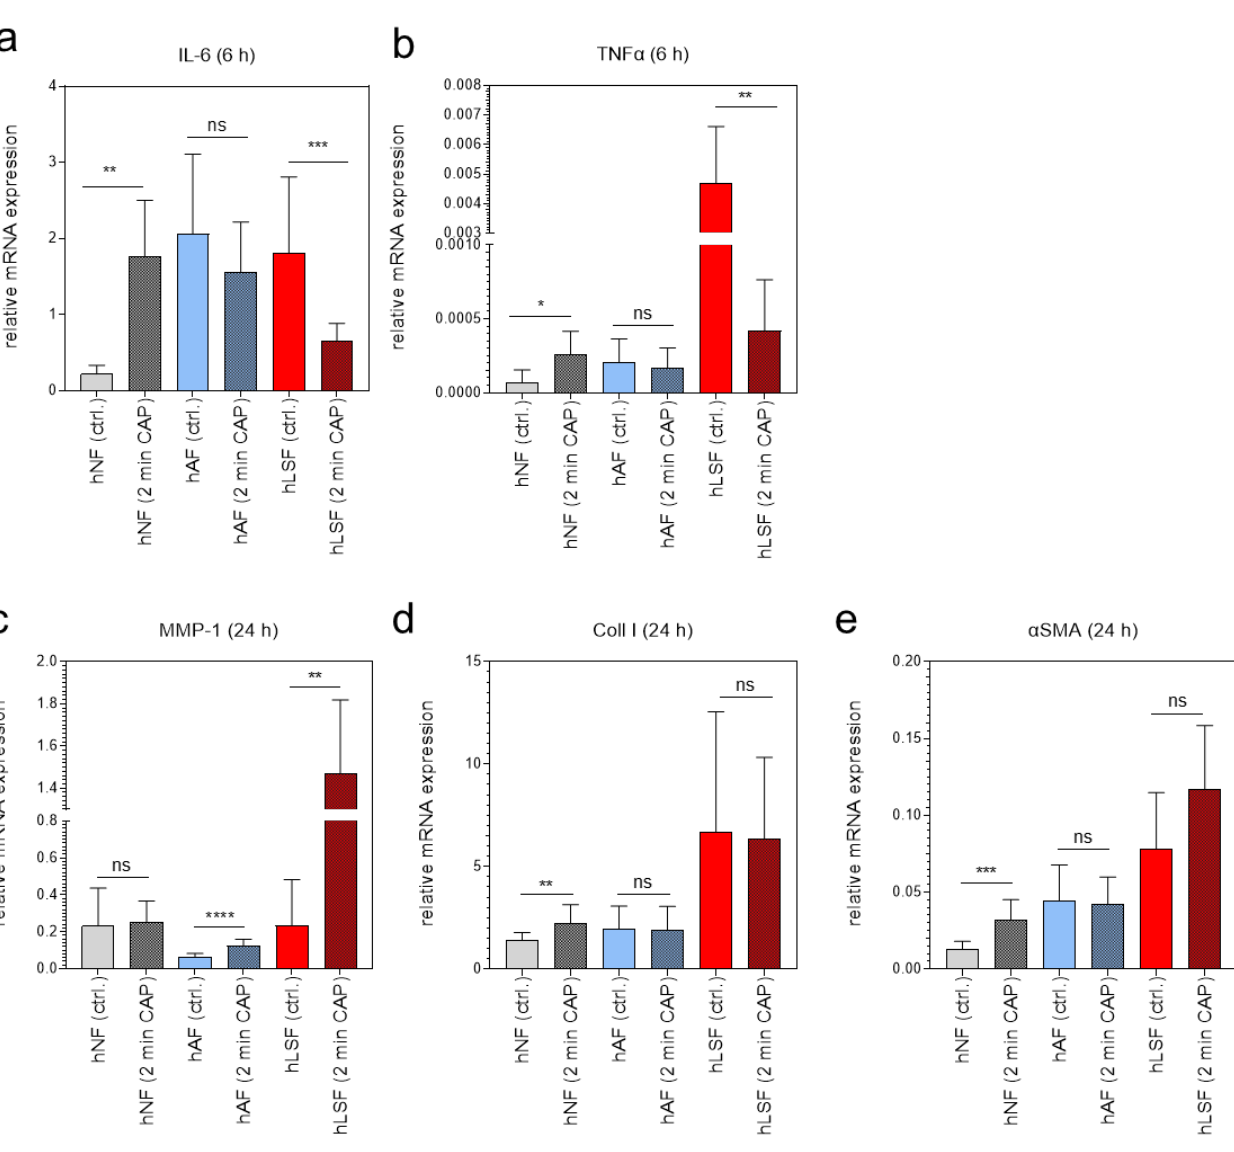
Figure 3. Paracrine effects of CAP on normal, activated, and LS-derived fibroblasts analyzed by mRNA expression of inflammatory- and fibrotic-associated marker genes. The relative mRNA expression of IL-6 ( a ) and TNF α ( b ) was analyzed 6 h, and the expression of MMP-1 ( c ), Coll 1 ( d ) and α SMA ( e ) in hNF, hAF, and hLSF 24 h after co-culture with hEK CAP-treated for 2 min and compared to the corresponding untreated controls ( n = 3 in duplicated form). Statistical analysis: The Student’s unpaired t test and the nonparametric Mann–Whitney test were used to show differences between the medians of two groups. Significant results compared to the corresponding untreated control are indicated * p ≤ 0.05, ** p < 0.01, *** p < 0.001, **** p < 0.0001; ns = not